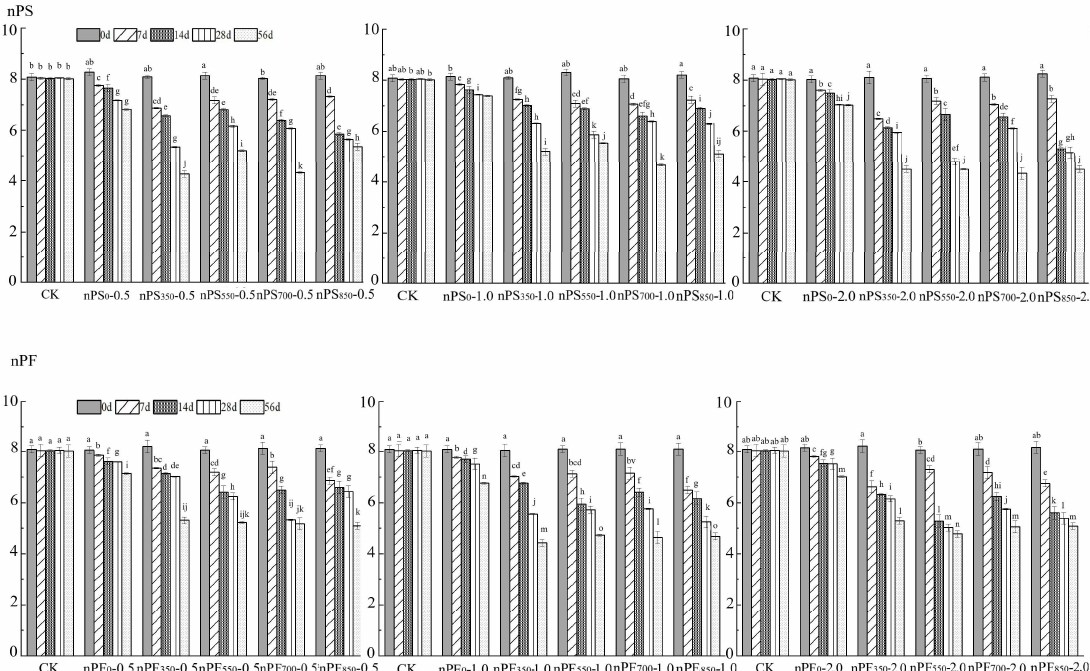
Figure 3. Effect of different treatments on the soil’s exchangeable Cd content. Different lower-case letters marked in Figure 3 indicate a significant difference across different treatments ( p < 0.05). Error bars ( n = 3, Mean ± SD). In the nPF treatments, compared to nPF 0 -0.5, the exchangeable Cd decreased by 25.53%, 26.65%, 28.75%, and 28.61%, respectively, in nPF 350 -0.5, nPF 550 -0.5, nPF 700 -0.5, and nPF 850 -0.5. Compared to nPF 0 -1.0, exchangeable Cd decreased by 24.54%, 27.96%, 31.81%, and 27.53%, re- spectively, in nPF 350 -1.0, nPF 550 -1.0, nPF 700 -1.0, and nPF 850 -1.0. Compared to nPF 0 -2.0, exchangeable Cd decreased by 34.47%, 31.36%, 42.01%, and 41.72%, respectively, in nPF 350 -2.0, nPF 550 -2.0, nPF 700 - 2.0, and nPF 850 -2.0. Compared to CK, the exchangeable Cd content of nPF 0 -0.5, nPF 0 -1.0, and nPF 0 - 2.0 treatments reduced by 0.25–11.10%, 0–12.59%, and 0.74–15.71%, respectively; the content of nPF 350 -0.5, nPF 350 -1.0, and nPF 350 -2.0 reduced by 1.36–33.79%, 0.50–34.04%, and 1.49–44.76%, respec- tively; the content of nPF 550 -0.5, nPF 550 -1.0, and nPF 550 -2.0 reduced by 0.37–34.79%, 0.12–40.40%, and 0.37–44.39%, respectively; and the content of nPF 850 -0.5, nPF 850 -1.0, and nPF 850 -2.0 reduced by 0.50– 36.53%, 0.12–36.66%, and 0.99–46.47%, respectively. The nPS700 additions reduced exchangeable Cd by 39.36–48.76% compared to CK, and nPF reduced it by 35.89–42.57%. The nPS was higher than previous results, such as a palygorskite addition that reduced exchangeable Cd by 11–32% [41] and single serpen- tine that reduced it by around 39% [28]. 4. Discussion 4.1. pH The pH value was found to have a negative correlation with DPTA-Cd [42]; thus, in our study, the increasing soil pH (Figure 1) led to the increase of the negative charge of colloid, and it increased the electrical adsorption of Cd 2+ . Cd 2+ can combine with CO 32− , OH − , and PO 43− to form insoluble CdCO 3 , Cd(OH) 2 , and Cd 3 (PO 4 ) 2 precipitation, with the increase of OH − concentration in soil solution. This reduces the availability of heavy met- als [43,44]. On the one hand, the pH values of serpentine and zeolite themselves are higher; on the other hand, both of them contain K + , Ca 2+ , and Mg 2+ , which increase the soil pH [45]. Furthermore, natural serpentine contains a large amount of OH − with strong chemical activities. The Mg-OH − bond in the soil solution undergoes proton migration to form new Mg-OH and MgO [38], and MgO hydrolyzes and improves pH value. 4.2. Cd Content